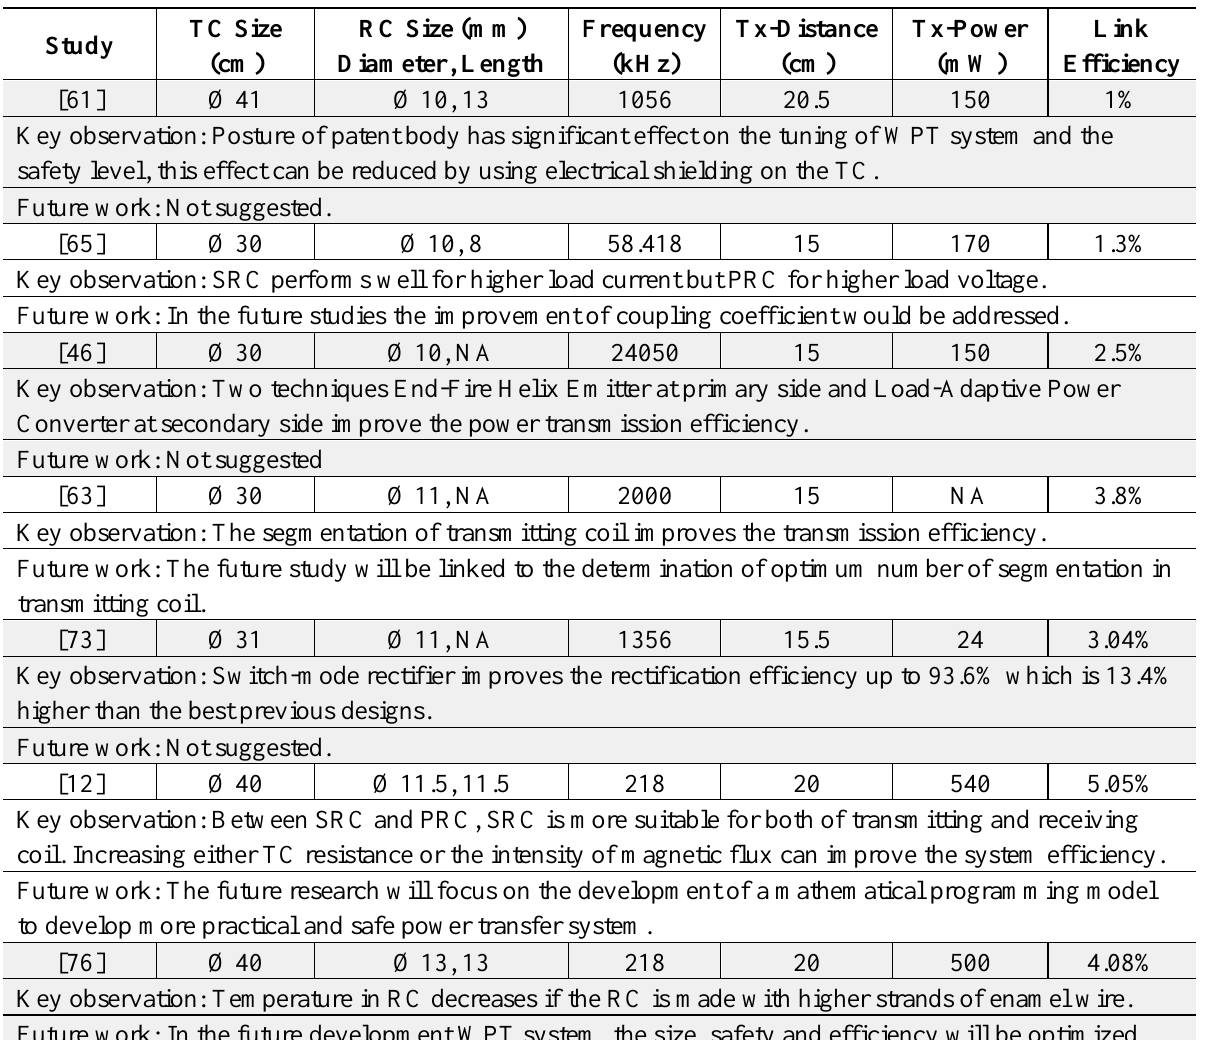
Table 4. Overview of solenoid coil-based WPT system